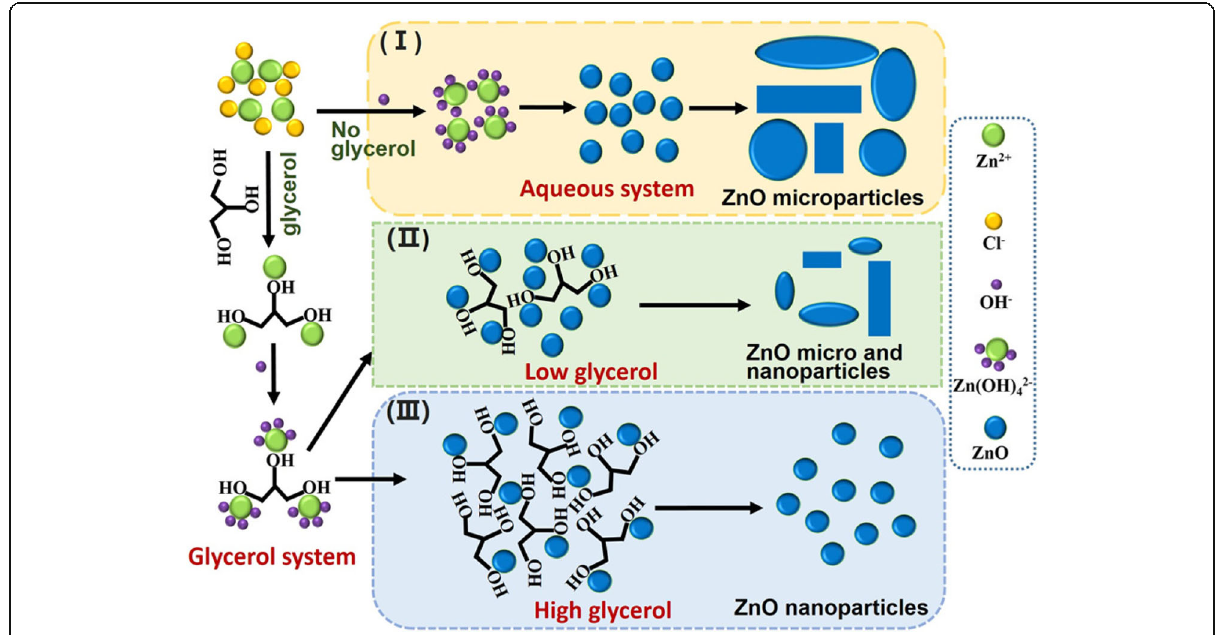
Fig. 2 Schematic presentation of glycerol role in the synthesis process of ZnO